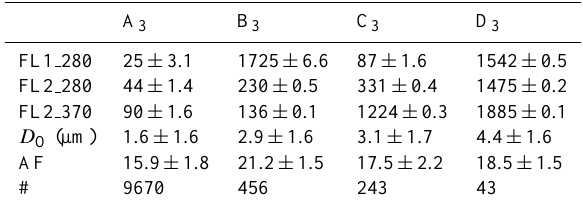
Fig. 7. Ambient WIBS4 data set clustering statistics. Ten cluster solution chosen due concomittent drop in R 2 and rise in RMS.